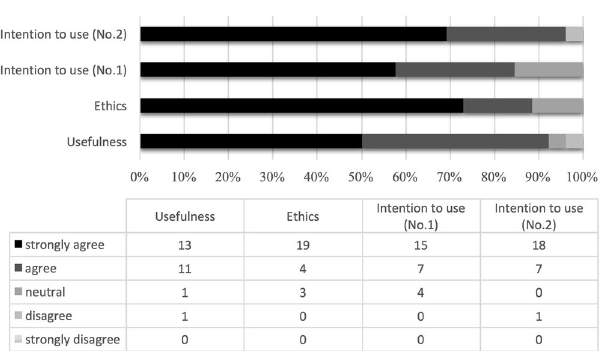
Figure 7. Constitutional ratios of evaluation to 3D-printed skulls. The darker the color is, the higher agreement to the statements in questionnaire. Detailed questions of subjective questionnaire shown in Table